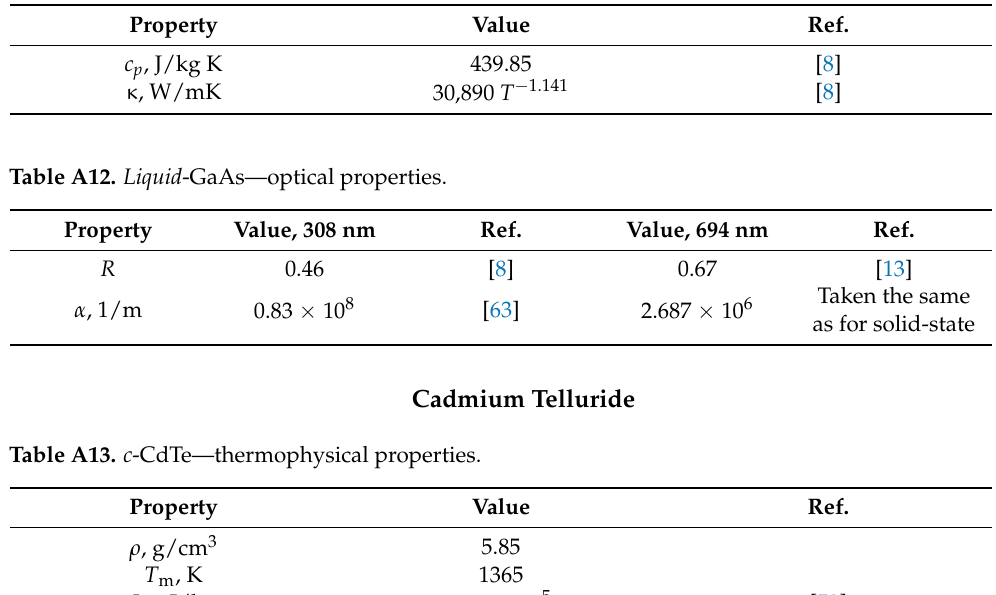
Table A11. Liquid -GaAs—thermophysical properties.